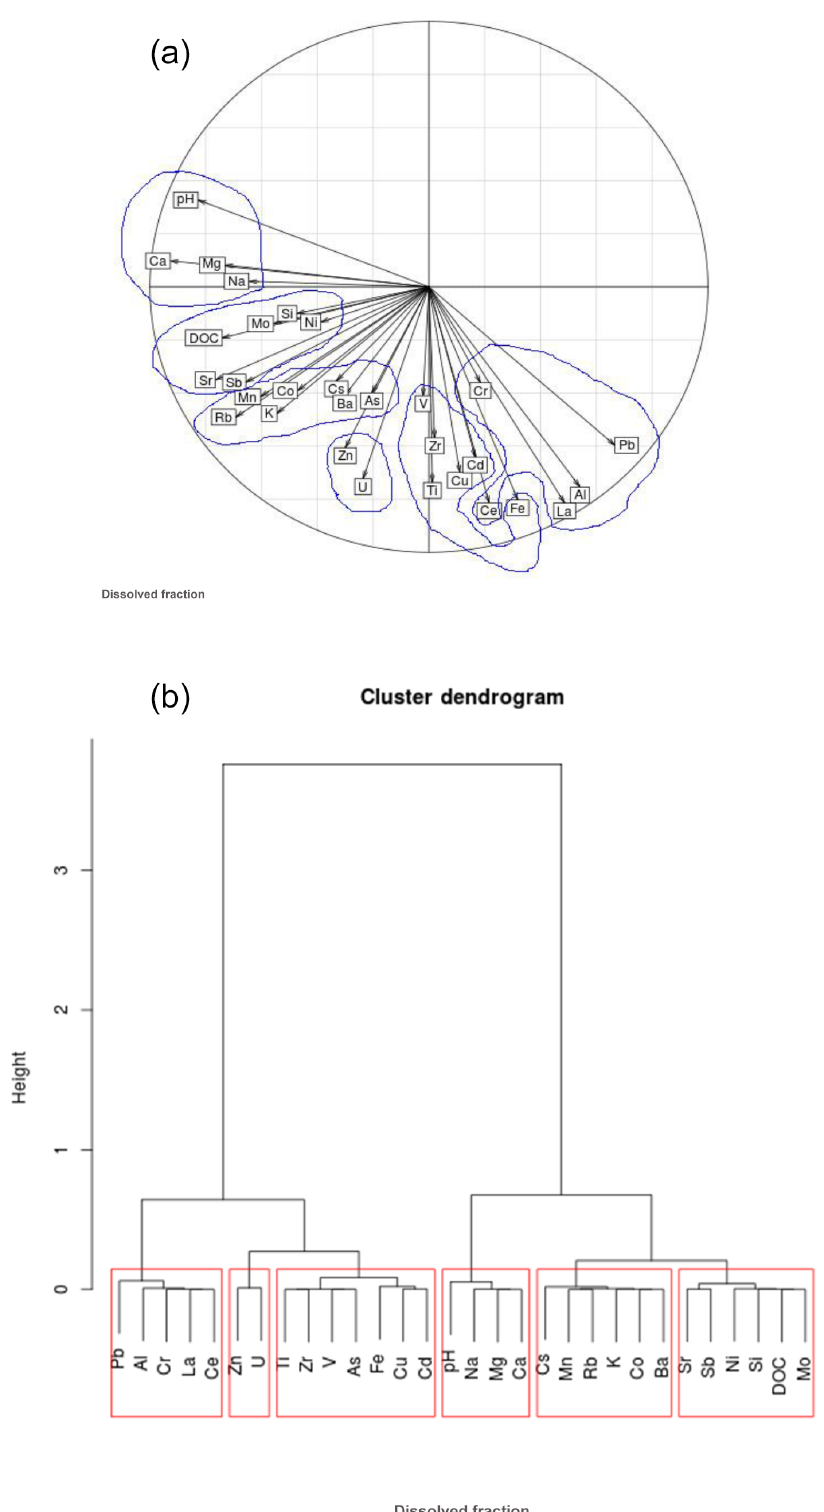
Figure 3. (a) PCA factorial map F1 × F2 of elements of a reconstructed table for the dissolved fraction. Partitioning of elements into six groups revealed by HCA is shown by a contour line. (b) Dendrogram of a hierarchical cluster analysis (HCA) performed on variables of a reconstructed table for the dissolved fraction using the Pearson correlation as a distance measure and Ward’s method for the linkage